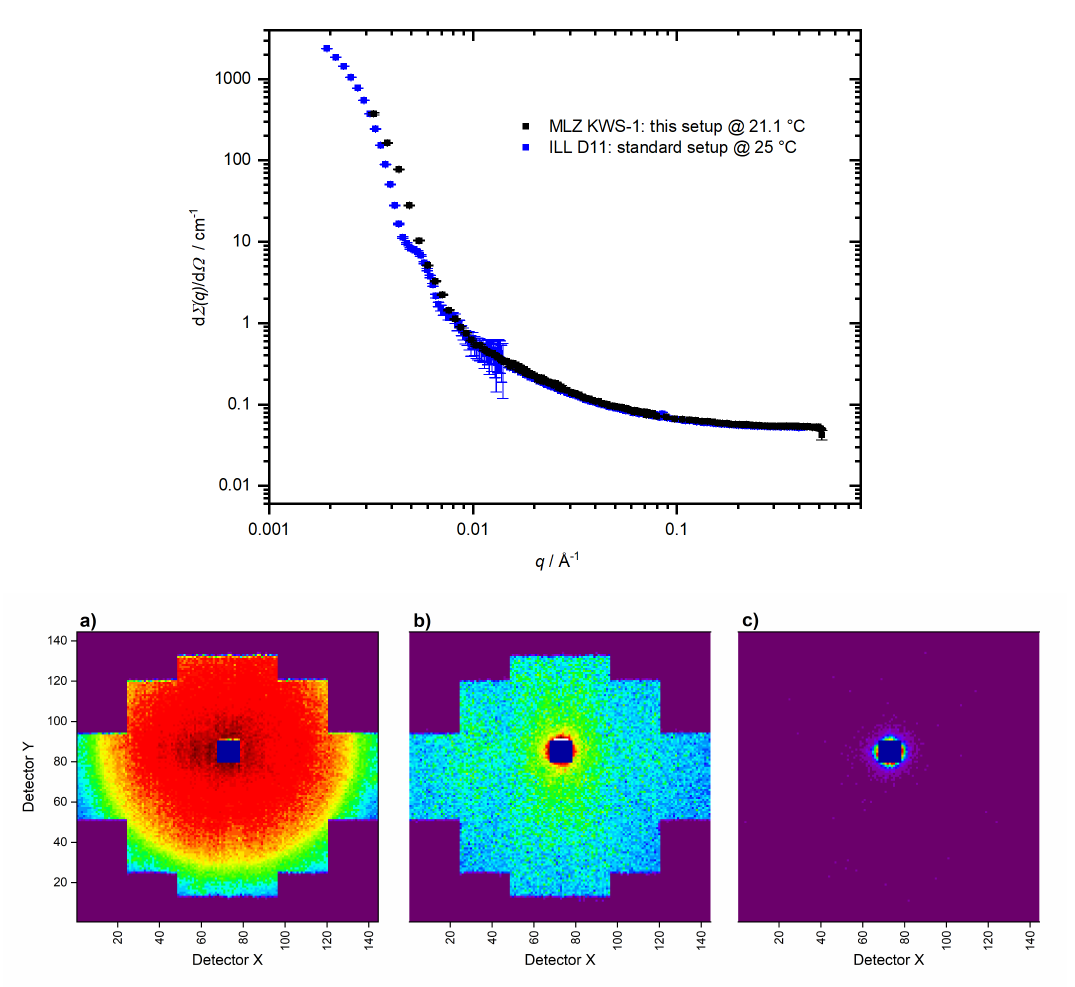
Figure 6. ( top ): SANS data measured employing the new sample environment from this work using the KWS1 machine at MLZ compared to SANS measurements made with the ILL standard setup at the D11 instrument. For both measurements, the same NIPMAM microgel sample as for the DLS measurements was used. ( bottom ): detector images for an empty cell measurement at 2m ( a ), 5m ( b ) and 20m ( c ). The reflections seen here, are caused by the large distance between the nose of the collimation system and the sample